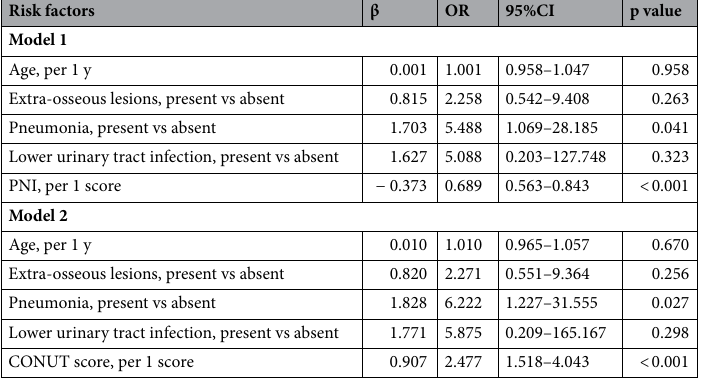
Table 5. Results of multivariate logistic analysis of the risk factors in participating patients with poor utilitarian results at one year. CONUT controlling nutritional status, PNI prognostic nutrition index, 95%CI 95% confidence interval, OR odds